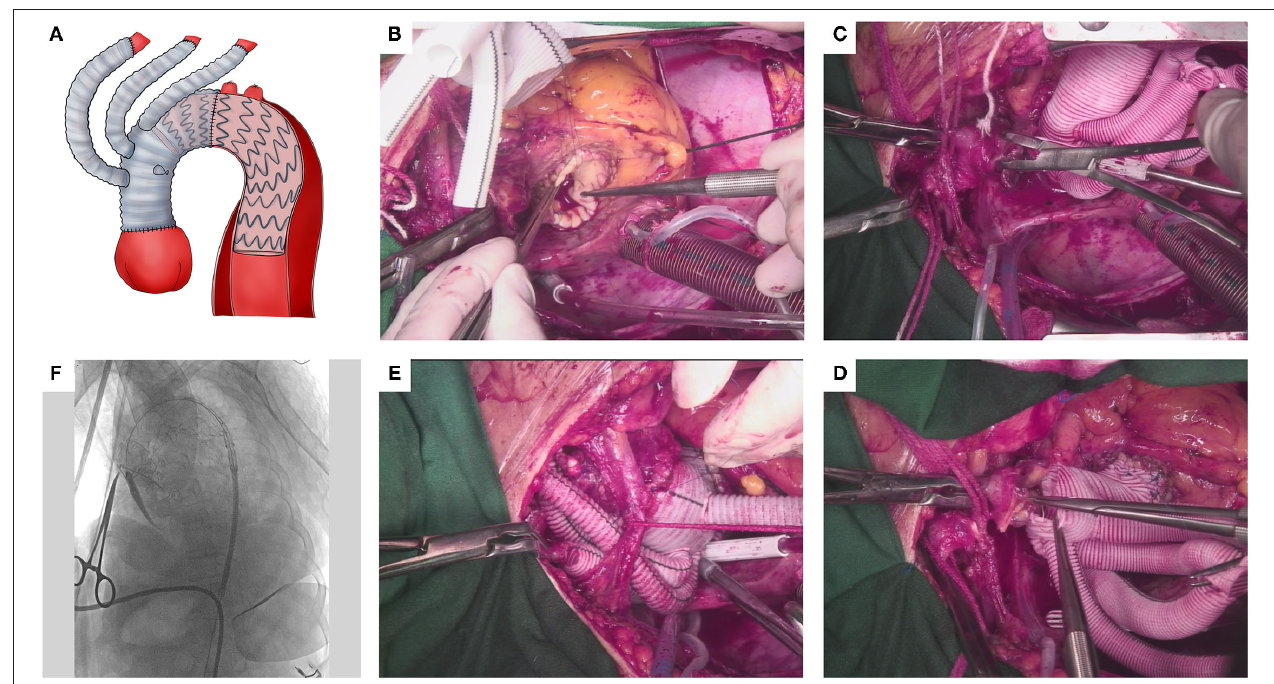
FIGURE 2 | Operative technique of HTAR. (A) Overall schematic diagram of HTAR: ascending aorta replacement, total supra-arch debranching and stent graft deployment to exclude the entire lesioned aortic arch. (B) Proximal anastomosis: the proximity of tetrafurcate vascular prosthesis graft was anastomosed to the sinotubular junction (aortic root has been repaired) by running suture with prolene. (C) Clamp site change: one aortic clamp was set on the aorta between the innominate artery and LCCA and another clamp was set on the innominate artery. The former aortic clamp on the ascending aorta could be removed. (D) Distal anastomosis: the distal anastomosis was made before the level of LCCA to ensure a sufficient proximal landing zone. (E) Supra-arch debranching: LCCA, LSCA and innominate artery were reconstructed by end-to-end anastomosis sequentially. (F) Endovascular portion: deploying a stent graft to exclude the entire lesioned aortic arch. HTAR, hybrid total arch replacement; LCCA, left common carotid artery; LSCA, left subclavian